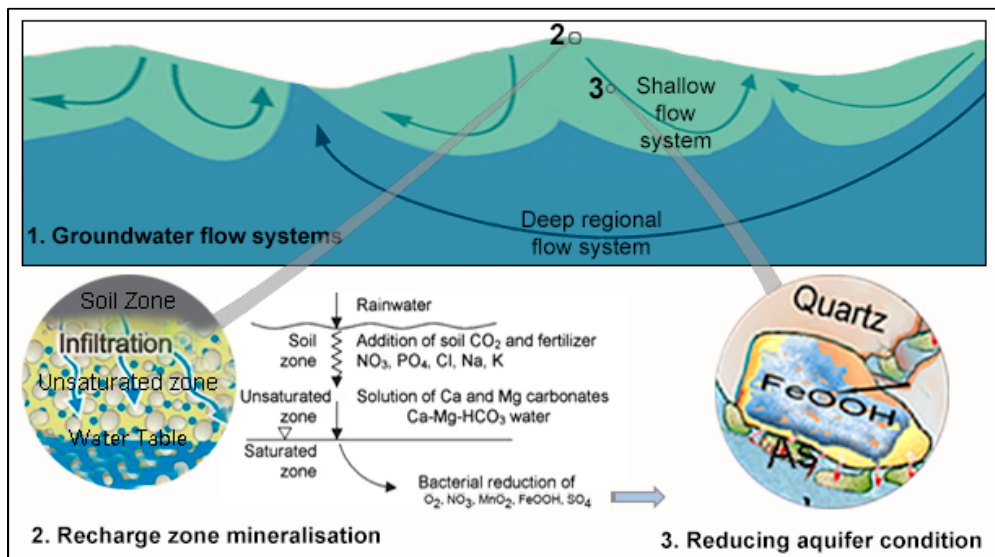
Figure 12 . Conceptual illustration of main controls and processes on water chemistry (recharge zone mineralisation [72], and microbial mediated redox reactions [73–75] driven by the biodegradation organic matter and involve the consumption of oxygen, nitrate, manganese- and iron-(hydro)oxides, and also sulfate) in Asian deltaic aquifers influencing groundwater quality and nutrient contents.